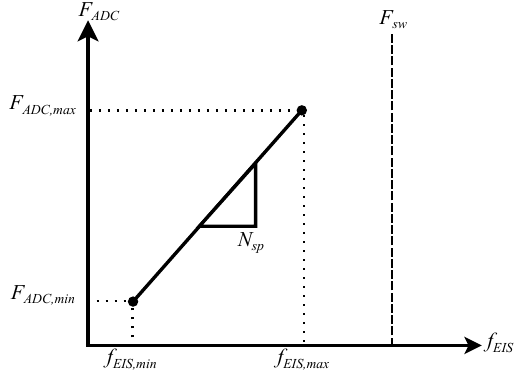
Figure 13. Interrelation of the different